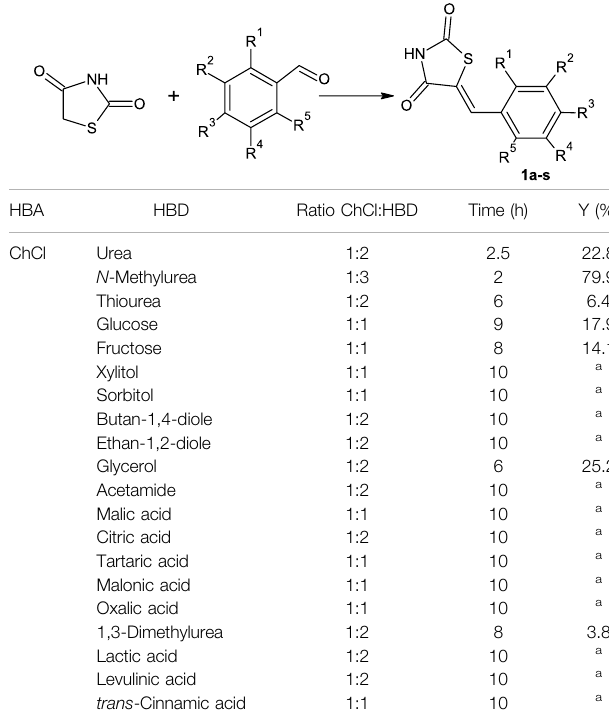
TABLE 1 | Reaction times and product yields obtained in different deep eutectic